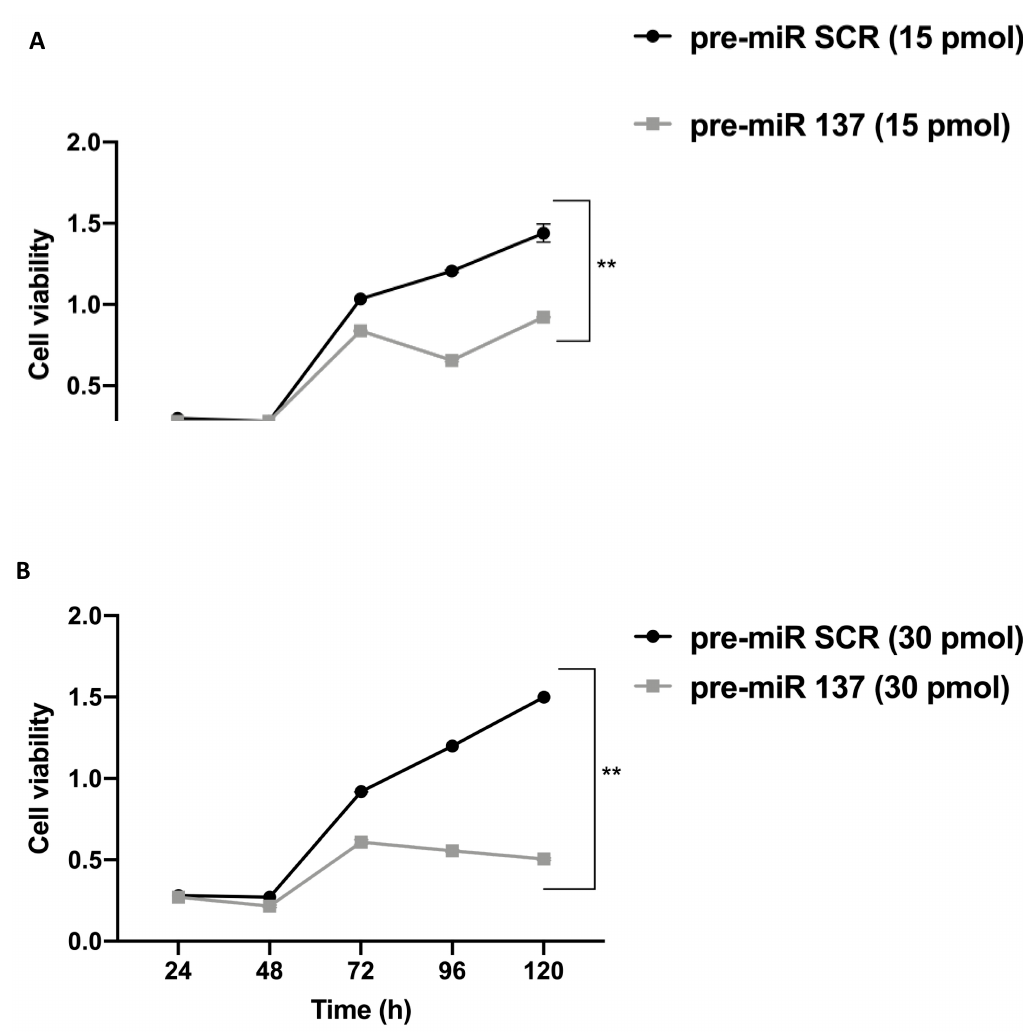
Figure 4. A 3-(4,5-dimethylthiazol-2-yl)-2,5-diphenyl-2H-tetrazolium bromide (MTT) assays was used to determine cell viability in SW480 cells transfected with 15 ( A ) and 30 ( B ) pmol pre-miR-137 and pre-miR SCR (negative control), from 24–120 h. MiR-137 overexpression significantly suppressed SW480 proliferation in a time- and dose-dependent manner (** p < 0.0001).